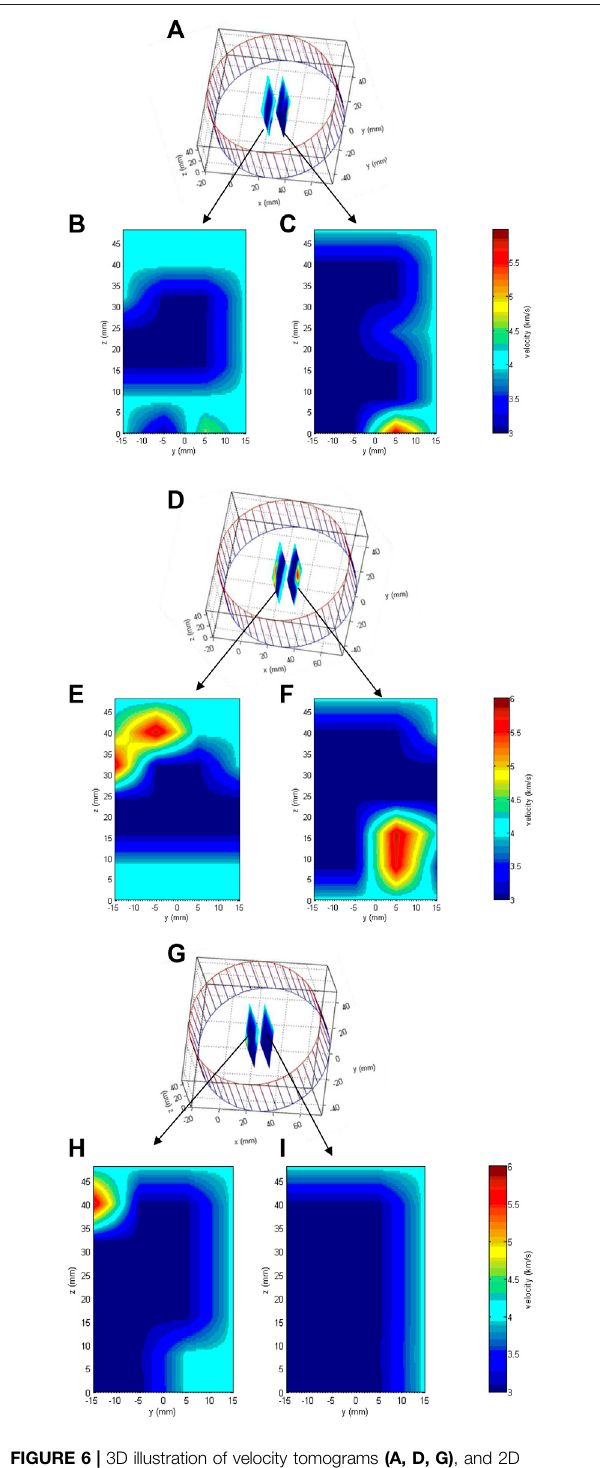
FIGURE 6 | 3D illustration of velocity tomograms (A, D, G) , and 2D velocity tomograms along the loading direction with the same distance to the centre at Stage I (B, C) , Stage II (E, F) and Stage III (G, I) of the Brazilian test.